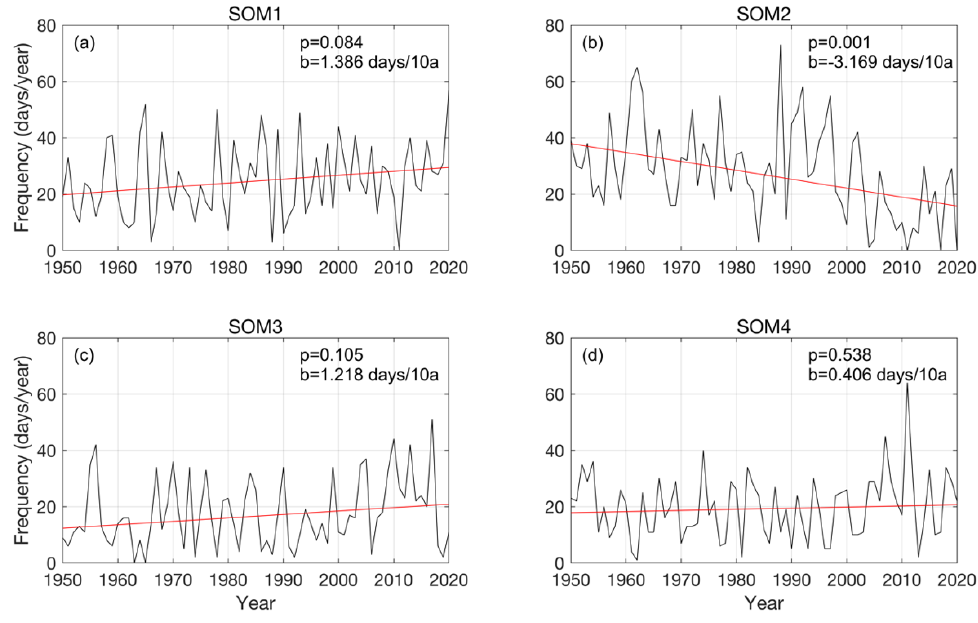
Figure 4. The occurrences of the four SOM groups in winters from 1950/1951 to 2020/2021. The frequency (in days/year) is counted yearly for SOM1 ( a ), SOM2 ( b ), SOM3 ( c ) and SOM4 ( d ). In each plot, the black line is the days classified to the corresponding SOM group. The red straight line is the linear trend of occurrence frequency with the p -value of the significance test b-value of the linear trend shown in the top-right corner of each panel.